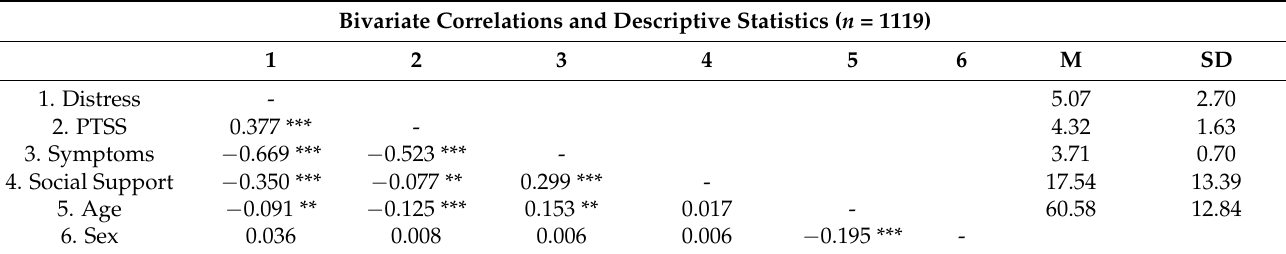
Table 2. Correlations and Descriptive Statistics for Key Study